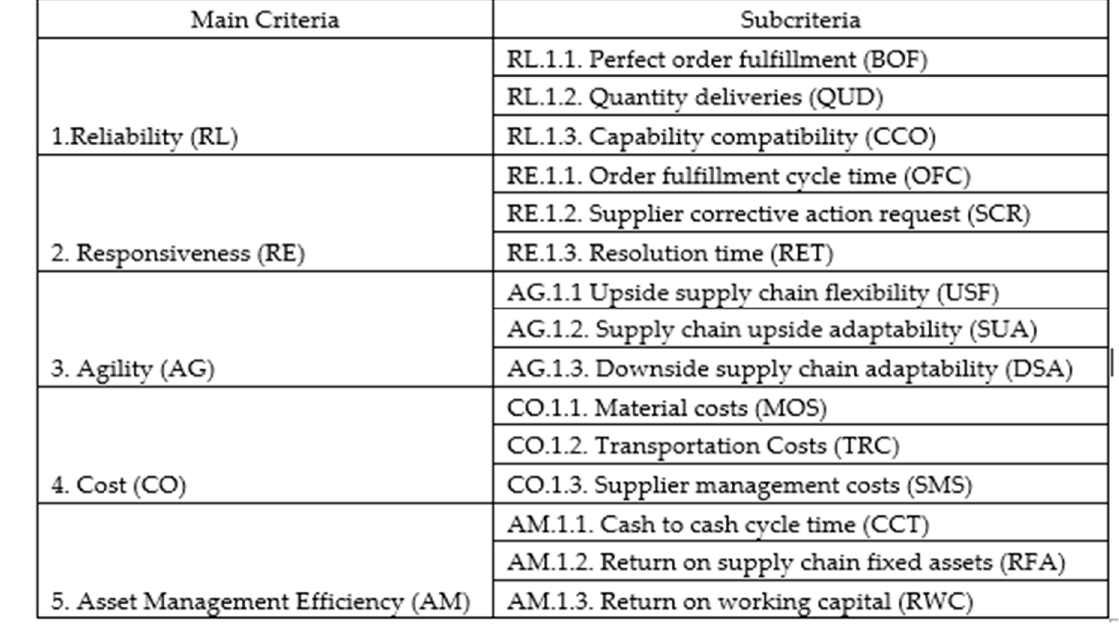
Table 2. The fuzzy comparison matrices for the goal.